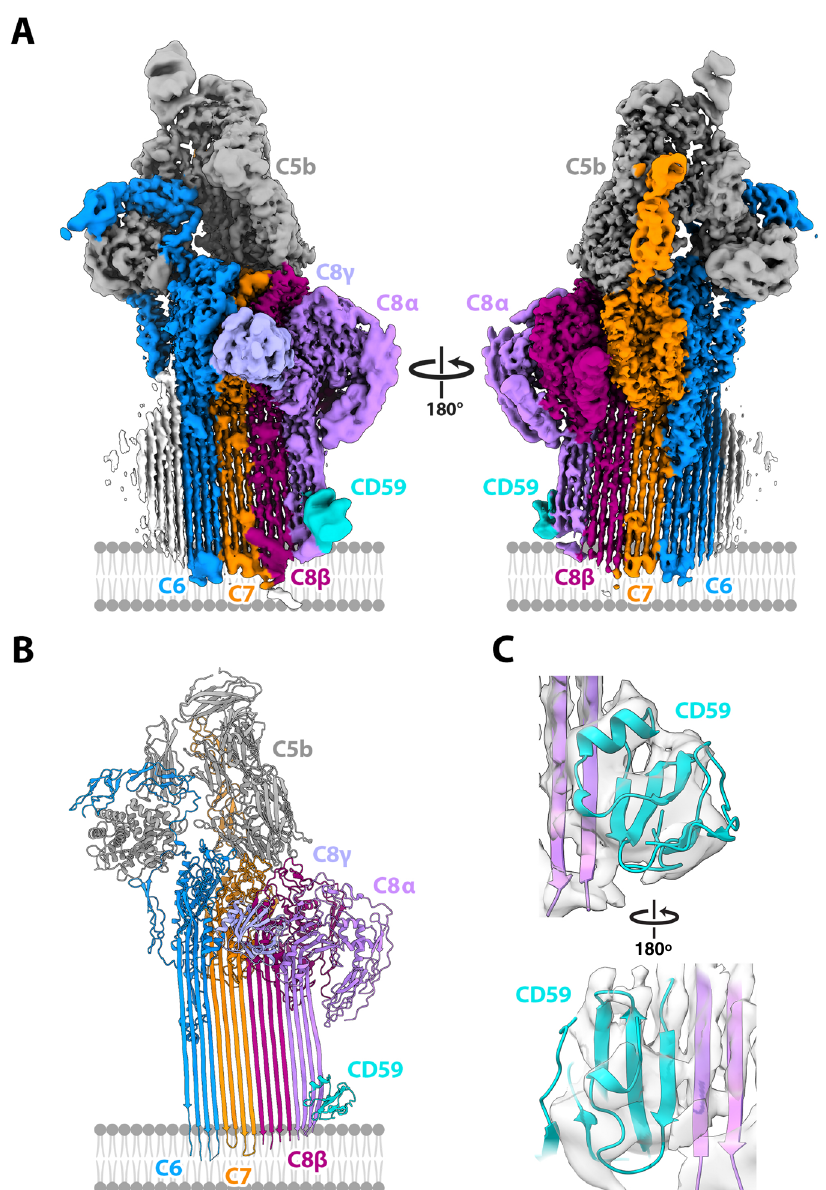
Fig.2|StructureoftheC5b8-CD59complex. CryoEMmap A andmodel B forthe C5b8-CD59 nanodisc complex. Complement proteins are colored (C5b, grey; C6, blue; C7, orange; C8 α , pink; C8 β , magenta; C8 γ light purple). CD59 is cyan. The membrane, not visible in the sharpened map, is schematized for reference. To